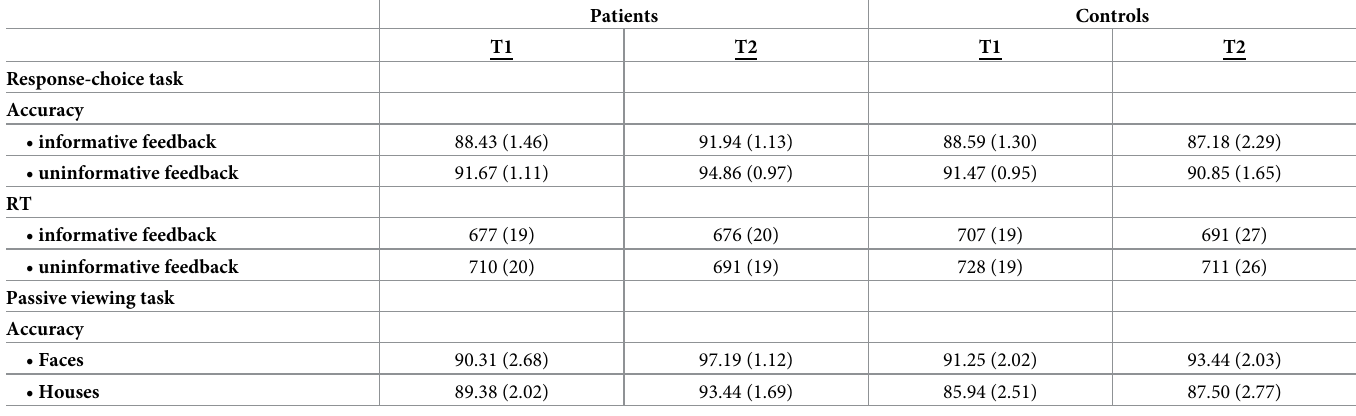
Table 2. Behavioral